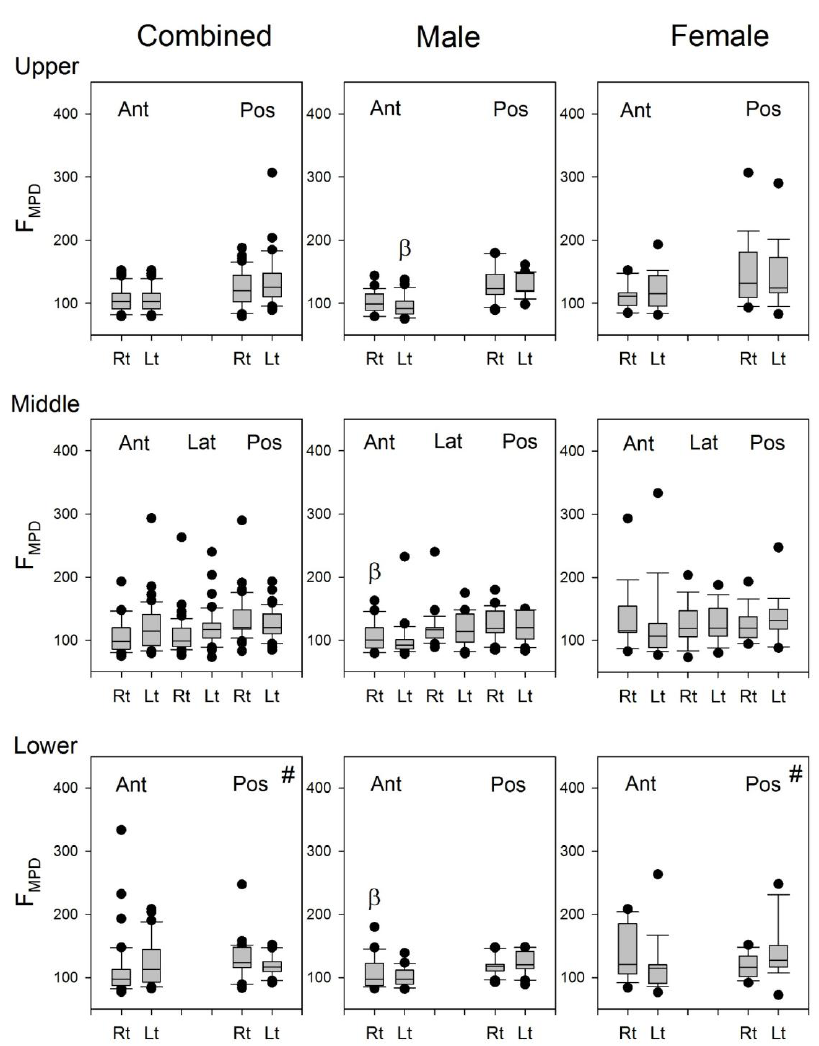
Figure 9. The boxplots of F MPD in the combined group, male group, and female group. #: Three of the 18 female subjects were excluded from the statistics because of excessive artifacts at this site. α : p < 0.05 between right and left lungs, β : p < 0.05 vs. its counterpart in the female subjects. Ant: anterior; Pos: posterior; Rt: right, Lt: